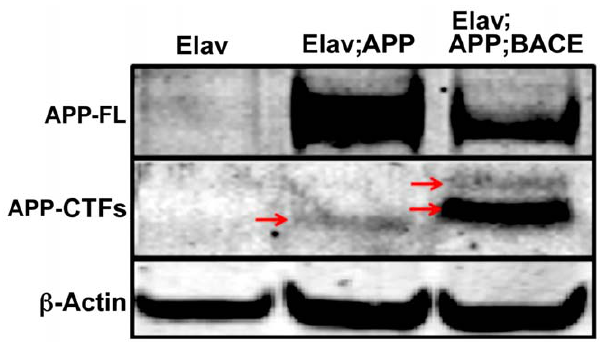
Figure 1. Transgene expression and proteolytic processing. Western blot analysis of human APP and fly b -actin detected in fly head lysates of: 1) elav ; + ; + heterozygous flies 2) elav ; APP ; + heterozygous flies, and 3) elav ; APP ; BACE heterozygous flies. APP-FL (full length APP, , 110 kD) and APP-CTFs (C terminal fragments, , 10–12 kD) were detected using A8717 (Sigma). Red arrows indicate a -CTF (lane 2) and b - CTFs (lane 3). A fly b -actin specific antibody was utilized (Abcam).